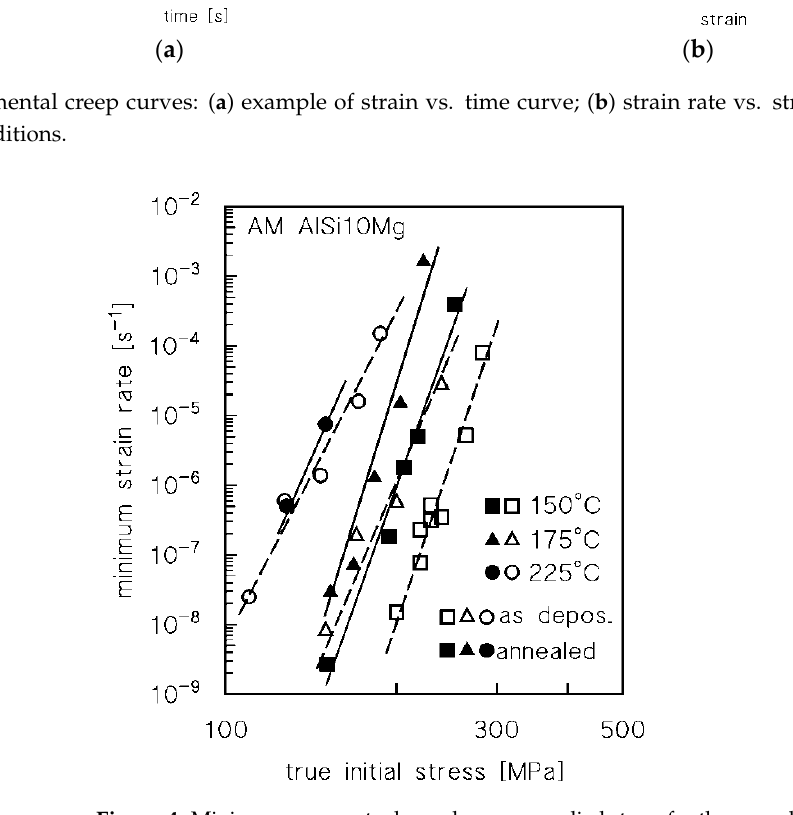
Figure 4. Minimum creep rate dependence on applied stress for the annealed and as-deposited [14] alloy.